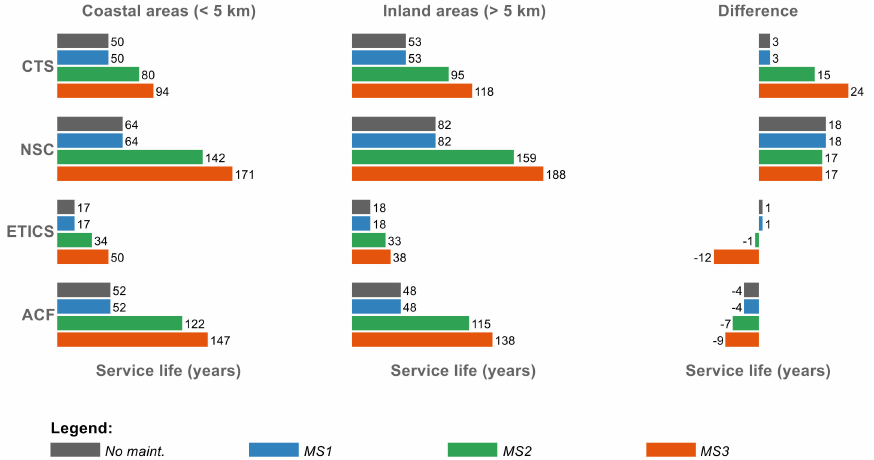
Figure 8. Comparison of the service life according to distance from the sea.